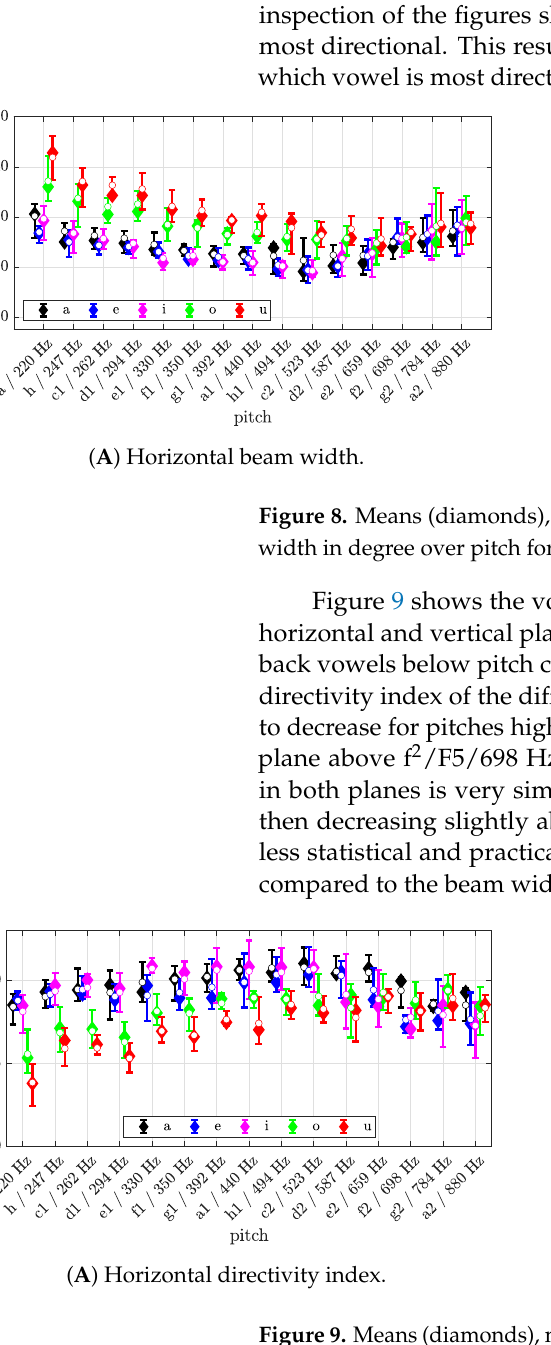
Figure 9. Means (diamonds), medians (dots), IQRs (whiskers) of the horizontal and vertical directivity index in dB over pitch for the female singers for the five vowels and all phonation